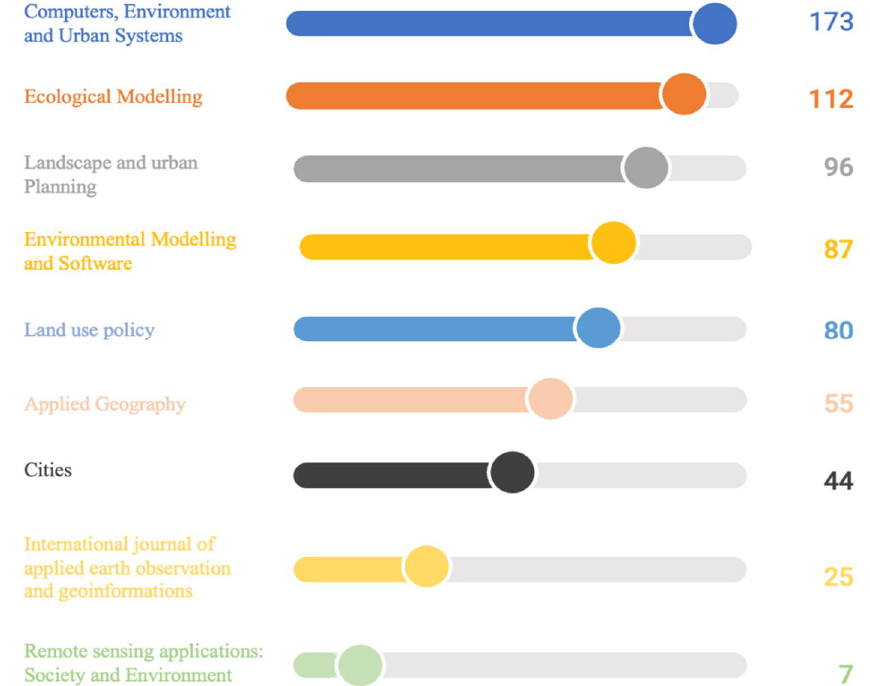
Figure 5. List of selected publication sources .